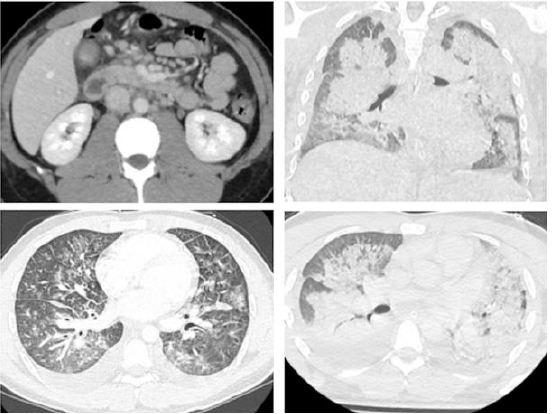
Figure 1. Computer tomography images ( Left —day 1, Right —day 5): intraabdominal lym- phadenopathy; pleural effusion, septal thickening, ground glass opacification and progressive parenchymal